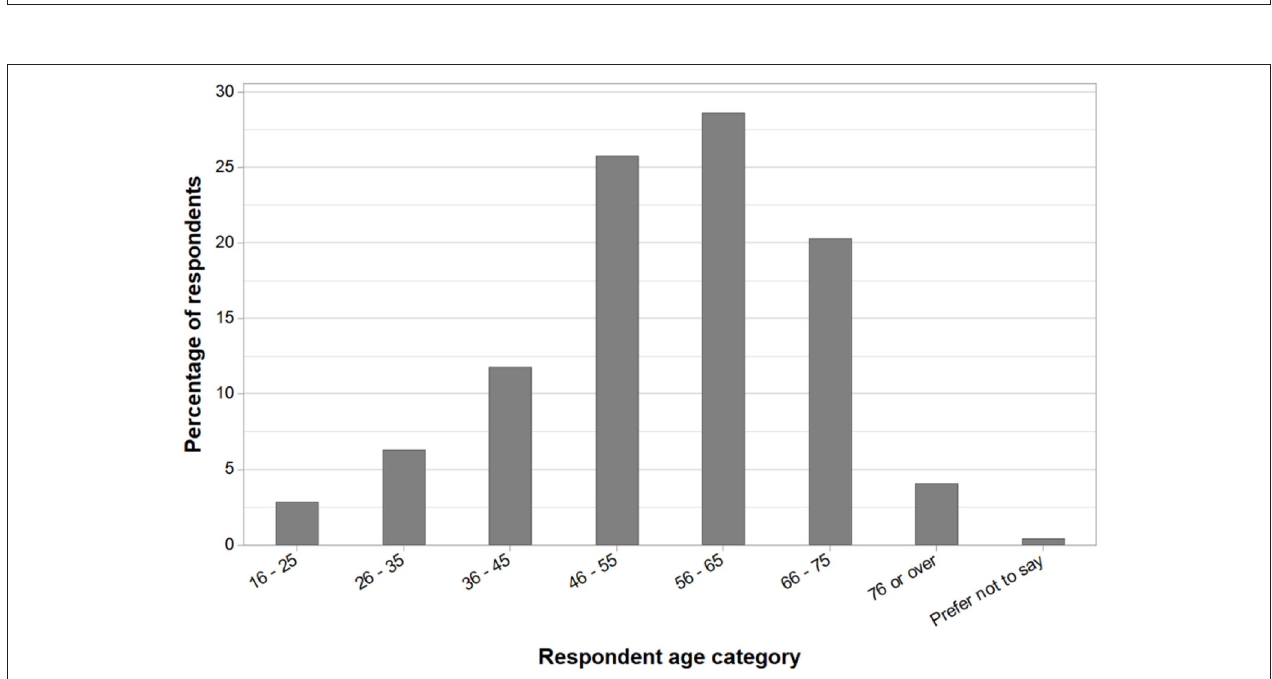
FIGURE 2 | Age of respondent was grouped into categories, as a percentage of respondents (Q27, n = 493). There were no respondents in the category “15 years or less.”